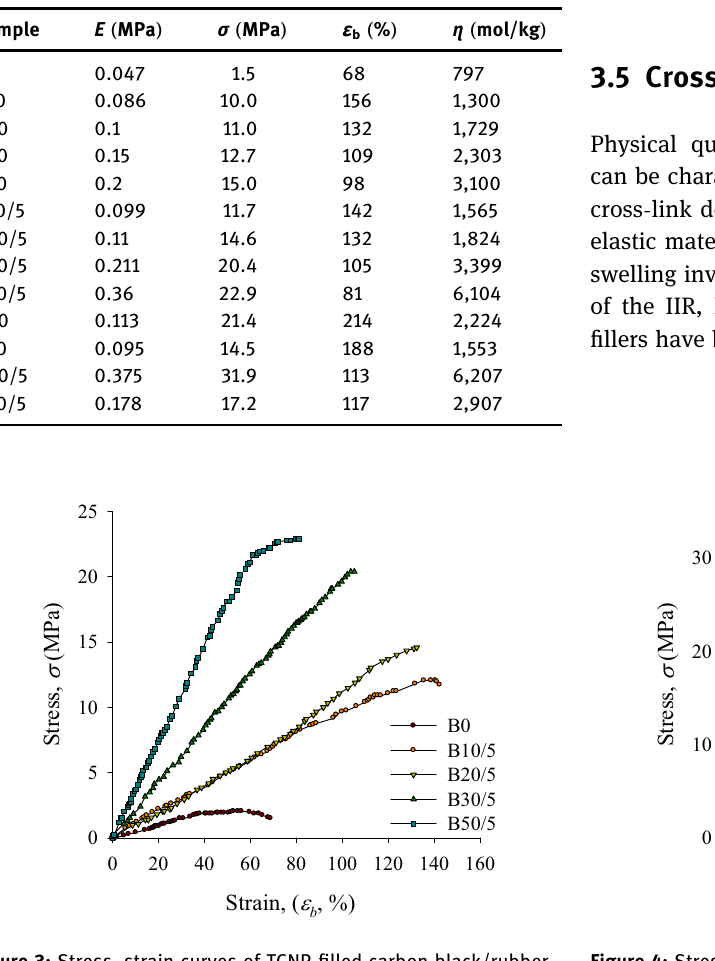
Figure 4: Stress – strain curves of di ff erent rubbers containing var - ious fi